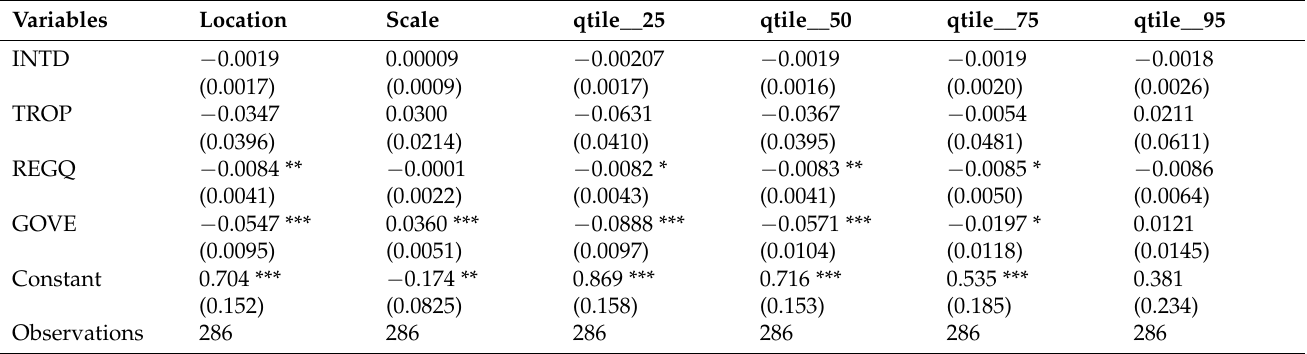
Table 9. Model 7. DV: Income Share of the Top 10%